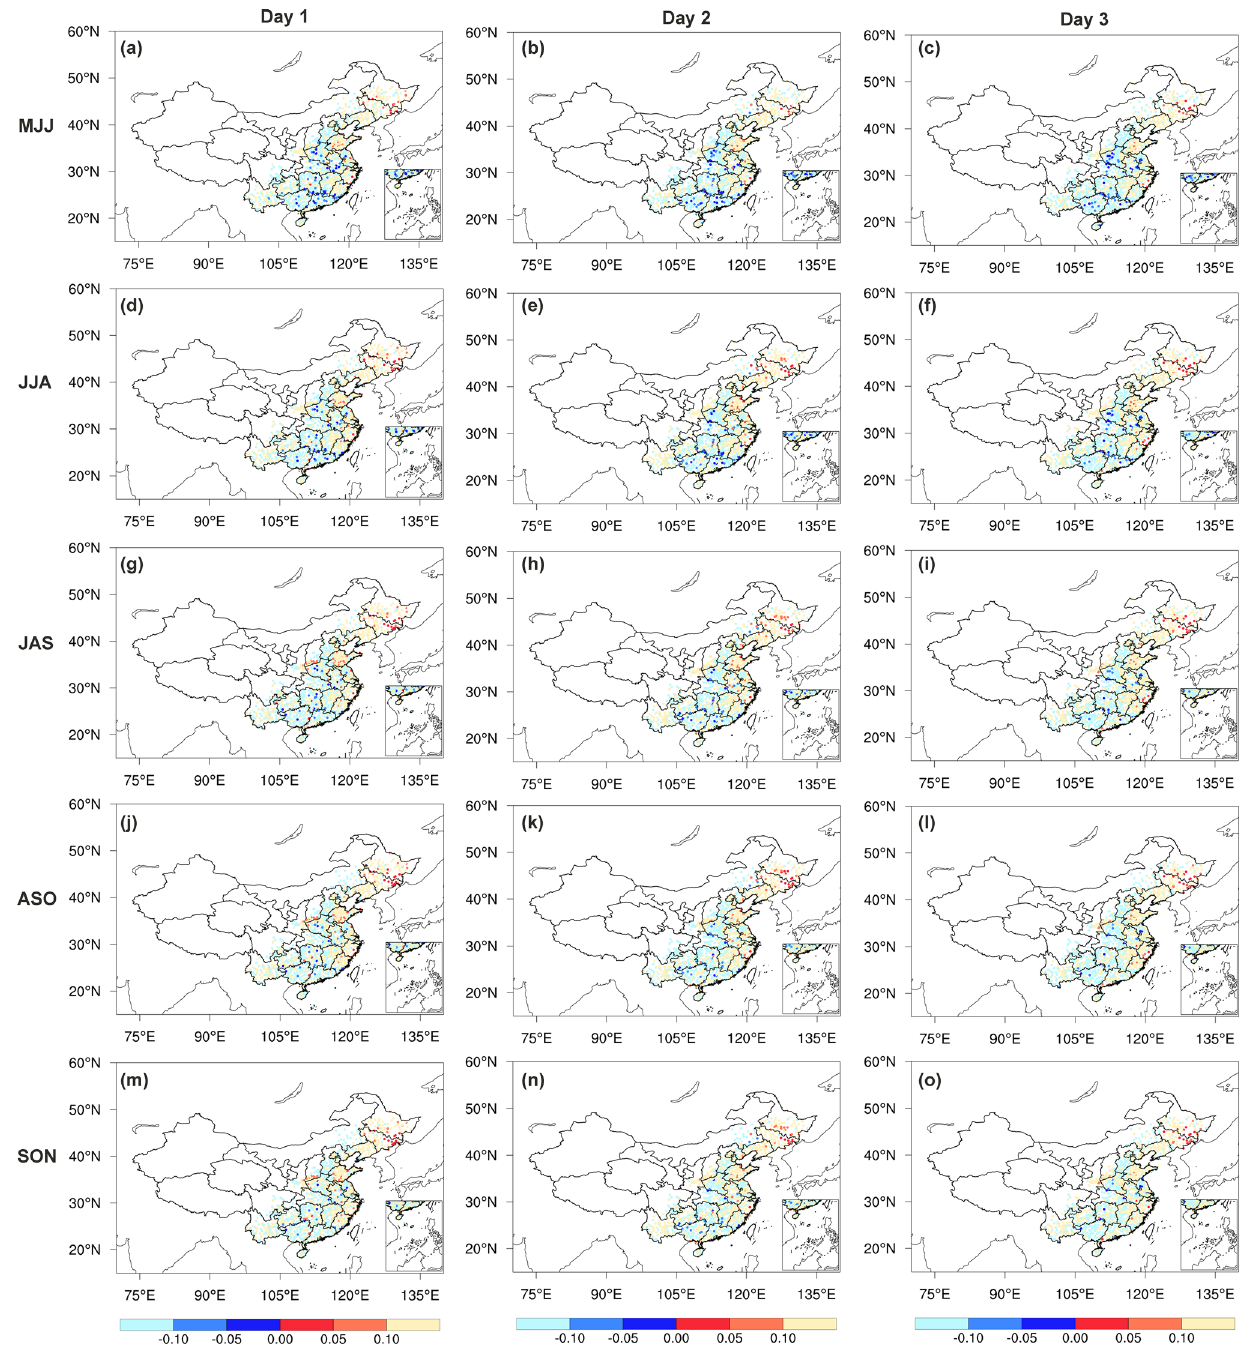
Fig. 7 Relationship between the tropical cyclone (TC)-induced annual maximum (AM) Day 1, Day 2, Day 3 precipitation and seasonal Nin˜o-3.4 values in the mainland of China. The relationship was identified based on logistic regression, and the color bars are p values of the b 1 coefficients. Negative p values (blue circles) represent that the b 1 coefficients are less than zero, indicating a relationship between ENSO and TC-induced extreme precipitation.